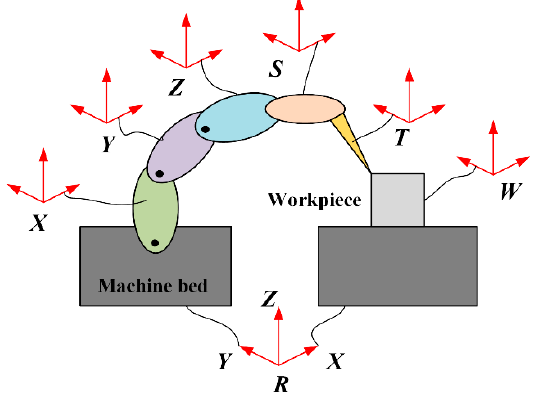
Figure 5. The coordinate system setting.